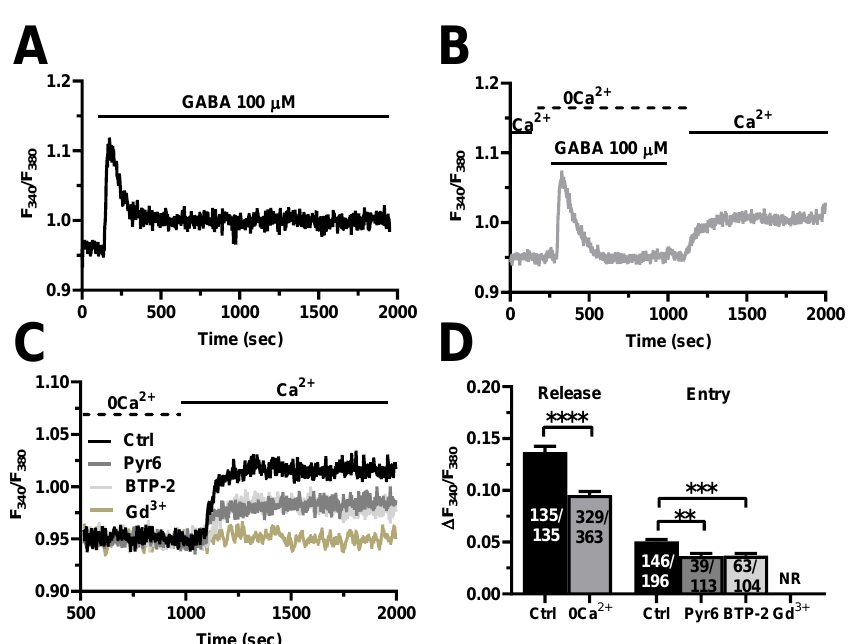
Figure 3. GABA evokes intracellular Ca 2+ release and SOCE activation in hCMEC/D3 cells. ( A ), representative tracing of the biphasic Ca 2+ response induced by GABA (100 µ M) in the presence of extracellular Ca 2+ (Ctrl). ( B ), representative tracing of the two distinct components of GABA-evoked intracellular Ca 2+ signals in hCMEC/D3 cells. GABA induced a transient increase in [Ca 2+ ] i in the absence of extracellular Ca 2+ (0Ca 2+ ), which is due to endogenous Ca 2+ mobilization. Restoration of extracellular Ca 2+ (1.5 mM) after removal of the agonist induced a second increase in [Ca 2+ ] i , which is indicative of SOCE activation. ( C ), GABA-evoked extracellular Ca 2+ entry was significantly reduced in the presence of Pyr6 (10 µ M, 10 min), BTP-2 (20 µ M, 10 min), or Gd 3+ (20 µ M, 10 min), three specific SOCE inhibitors. Intracellular Ca 2+ release is not shown. ( D ), mean ± SE of the amplitude of GABA-evoked Ca 2+ peaks in the presence (Ctrl) and absence (0Ca 2+ ) of extracellular Ca 2+ . **** indicate p < 0.0001 (Student’s t -test). Mean ± SE of the amplitude of GABA-evoked extracellular Ca 2+ entry in the absence (Ctrl) and presence of Pyr6, BTP-2 or Gd 3+ . *** indicate p < 0.001 and ** indicate p < 0.01 (one-way ANOVA followed by the post-hoc Dunnett’s test). NR indicates “No Response” as evaluated in 89 cells from three different